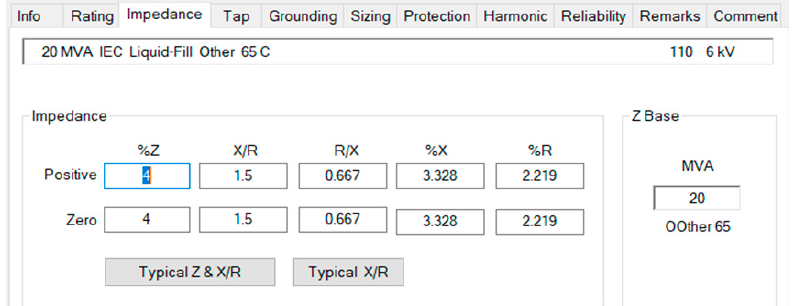
Figure 13. Percent impedance values for T2.